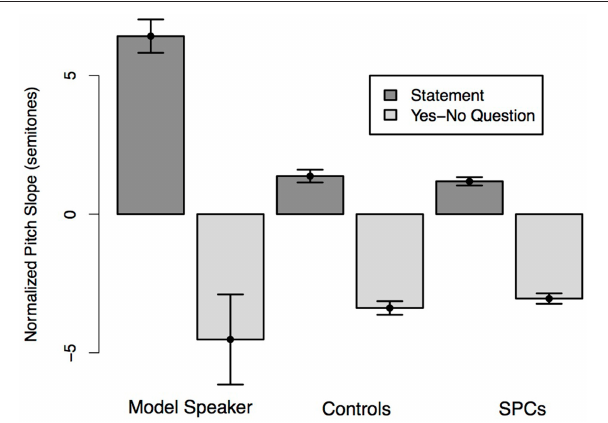
FIGURE 2 | Normalized pitch slope on the final word of Statements and Yes-No Questions as produced by the Model Speaker, Control Speakers, and SPCs. A positive pitch slope corresponds to a declination in F0 over the word; a negative slope corresponds to a F0 rise. Error bars represent standard